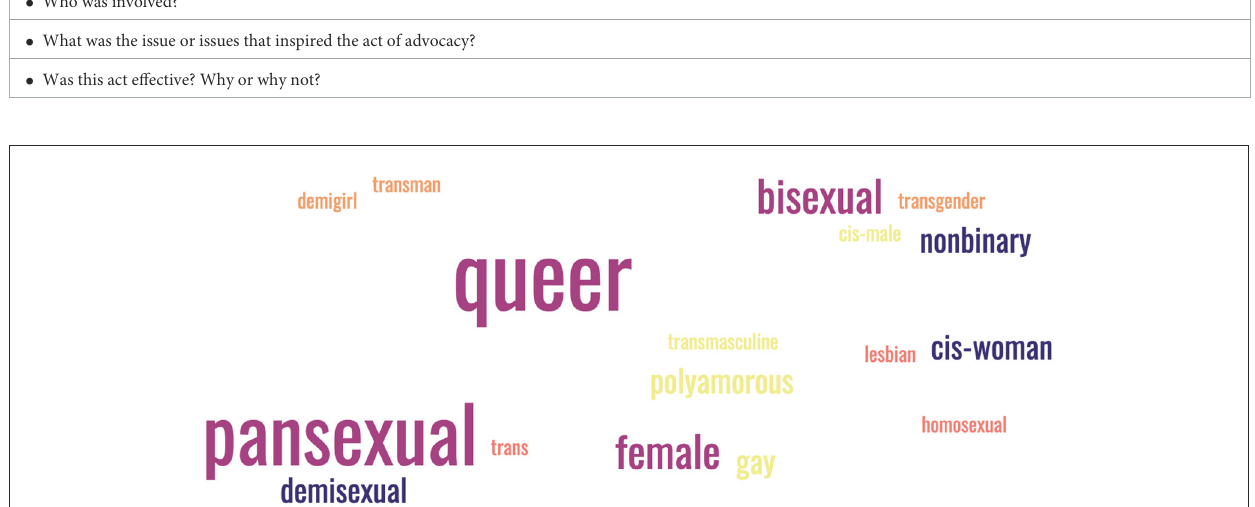
FIGURE1 Labels used by participants to describe their sexualities and gender identities.